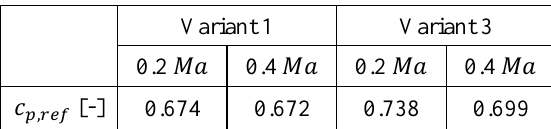
Table 5. Pressure recovery coefficient values – reference variant.